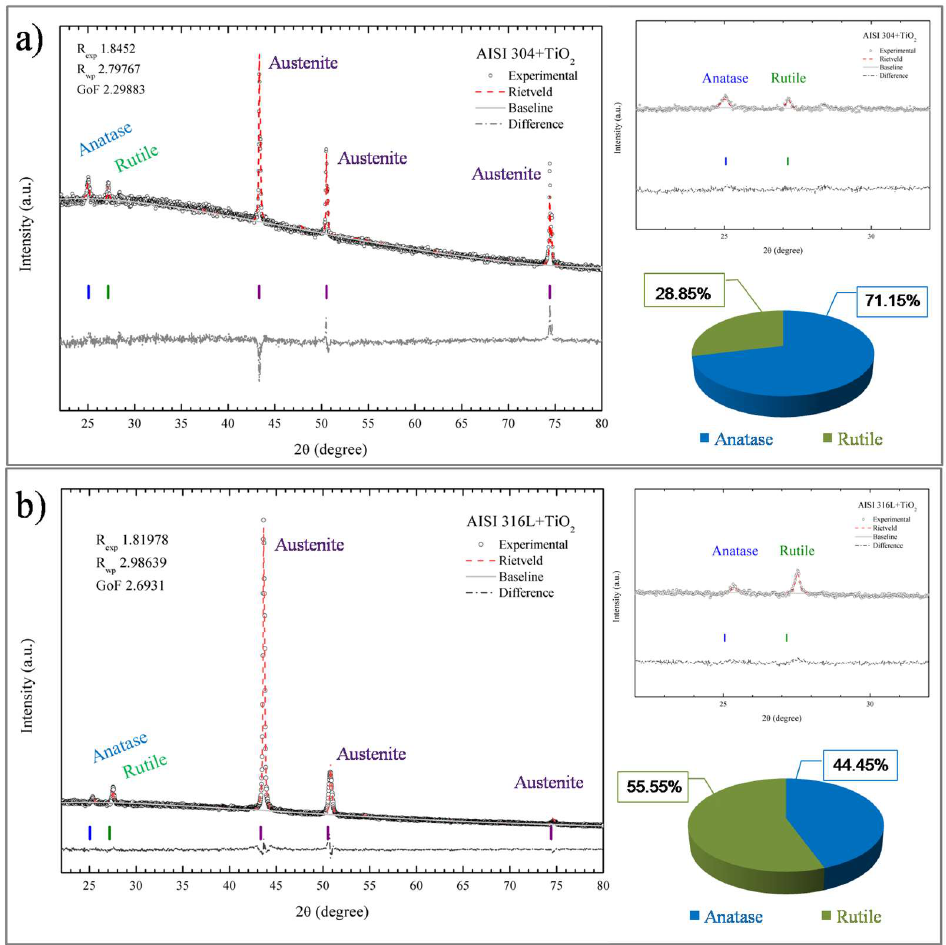
Figure 7. X-ray diffraction patterns of the TiO 2 films deposited on the AISI 304 ( a ) and AISI 316L ( b ) substrates, with refinement by the Rietveld method.